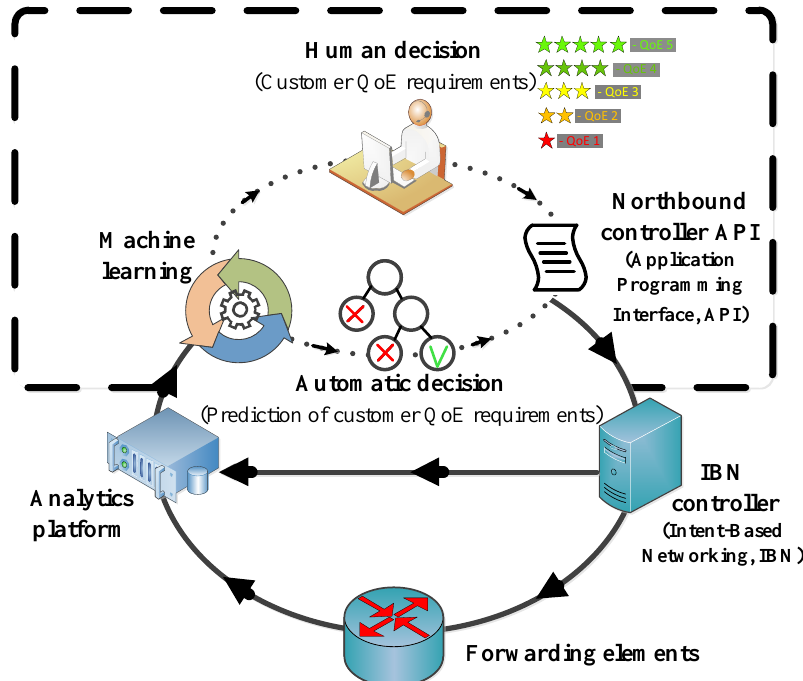
Figure 3. The proposed Intent-Based Networking concept using customer Quality of Experience (QoE) requirements.